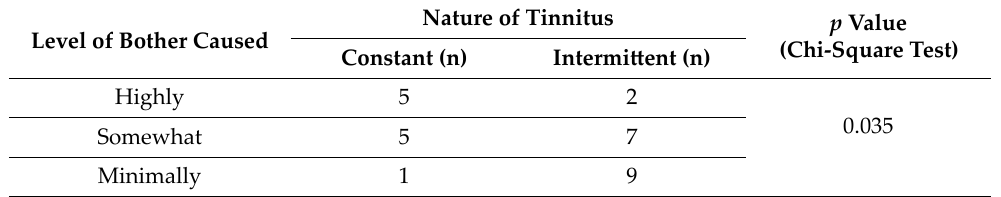
Table 5. Level of tinnitus bother caused in relation to tinnitus